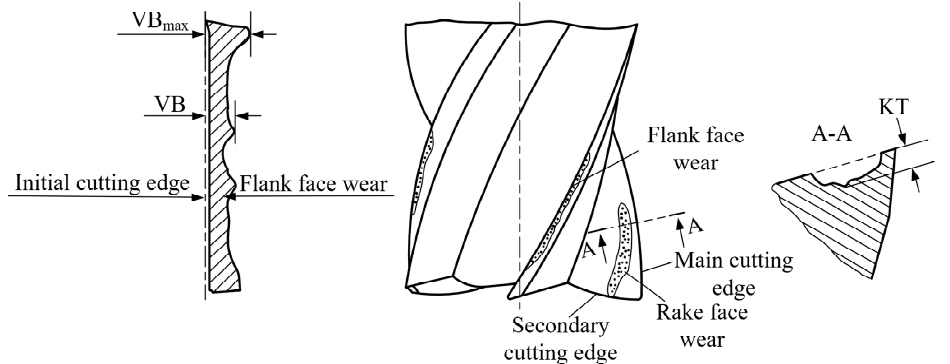
Figure 3. Wear Behavior of a Conventional Size End Milling Tool.